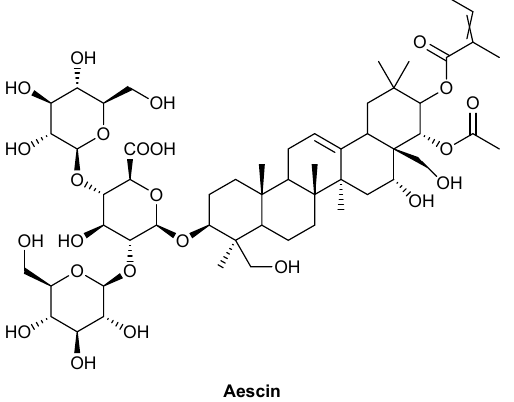
Figure 7. Chemical structure of aescin, the reported main active component of A. hippocastanum (L.), also referred as Horse chestnut seed extract.